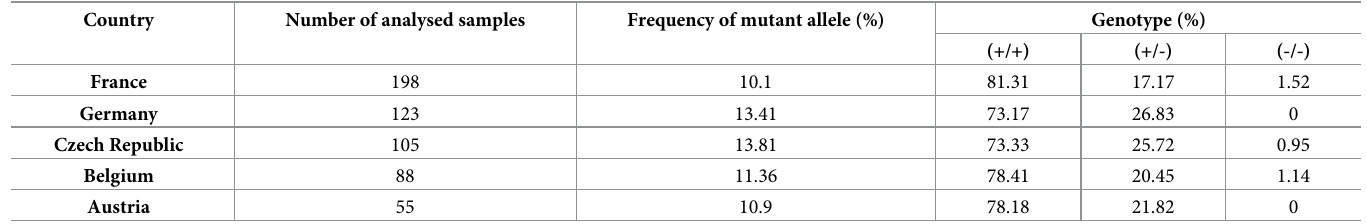
Table 5. Comparison of genotype and mutant allele frequencies in the top five countries for DM disease.